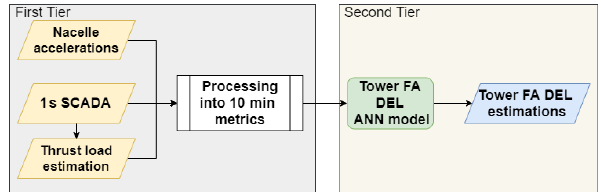
Figure 15. Schematic of tower FA DEL estimation ANN method-